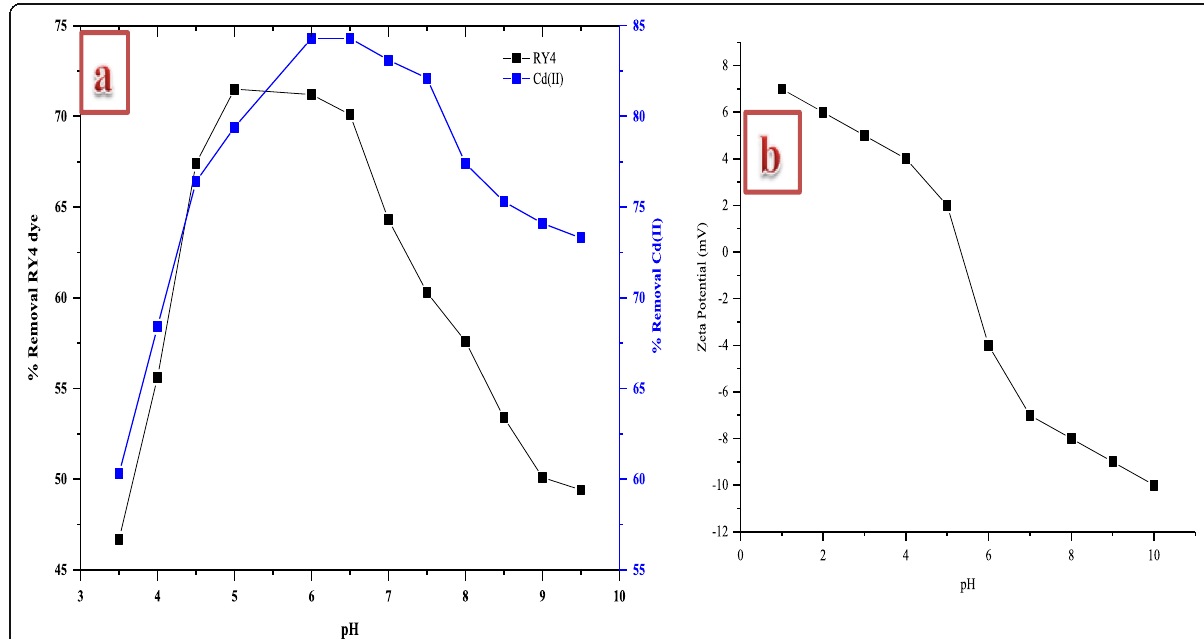
Fig. 9 a Effects of pH on the uptake of RY4 dye and Cd(II) ions (BMDA dosage (0.04 g/L), agitation time (120 min), agitation speed (150 rpm), initial adsorbate concentrations (240 mg/L) and temperature (30 °C)) and b Zeta Potential of